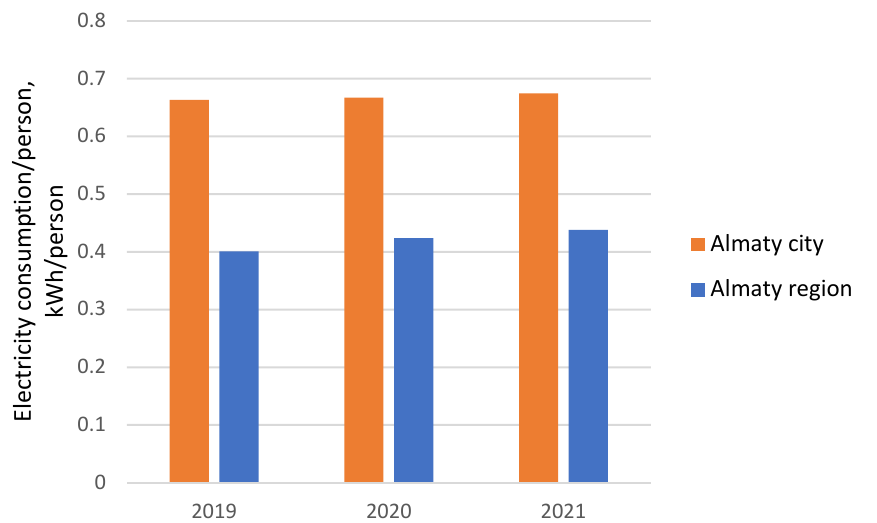
Figure 5. Electricity consumption by population (kWh/person) of Almaty city and Almaty region for 2019–2020–2021.